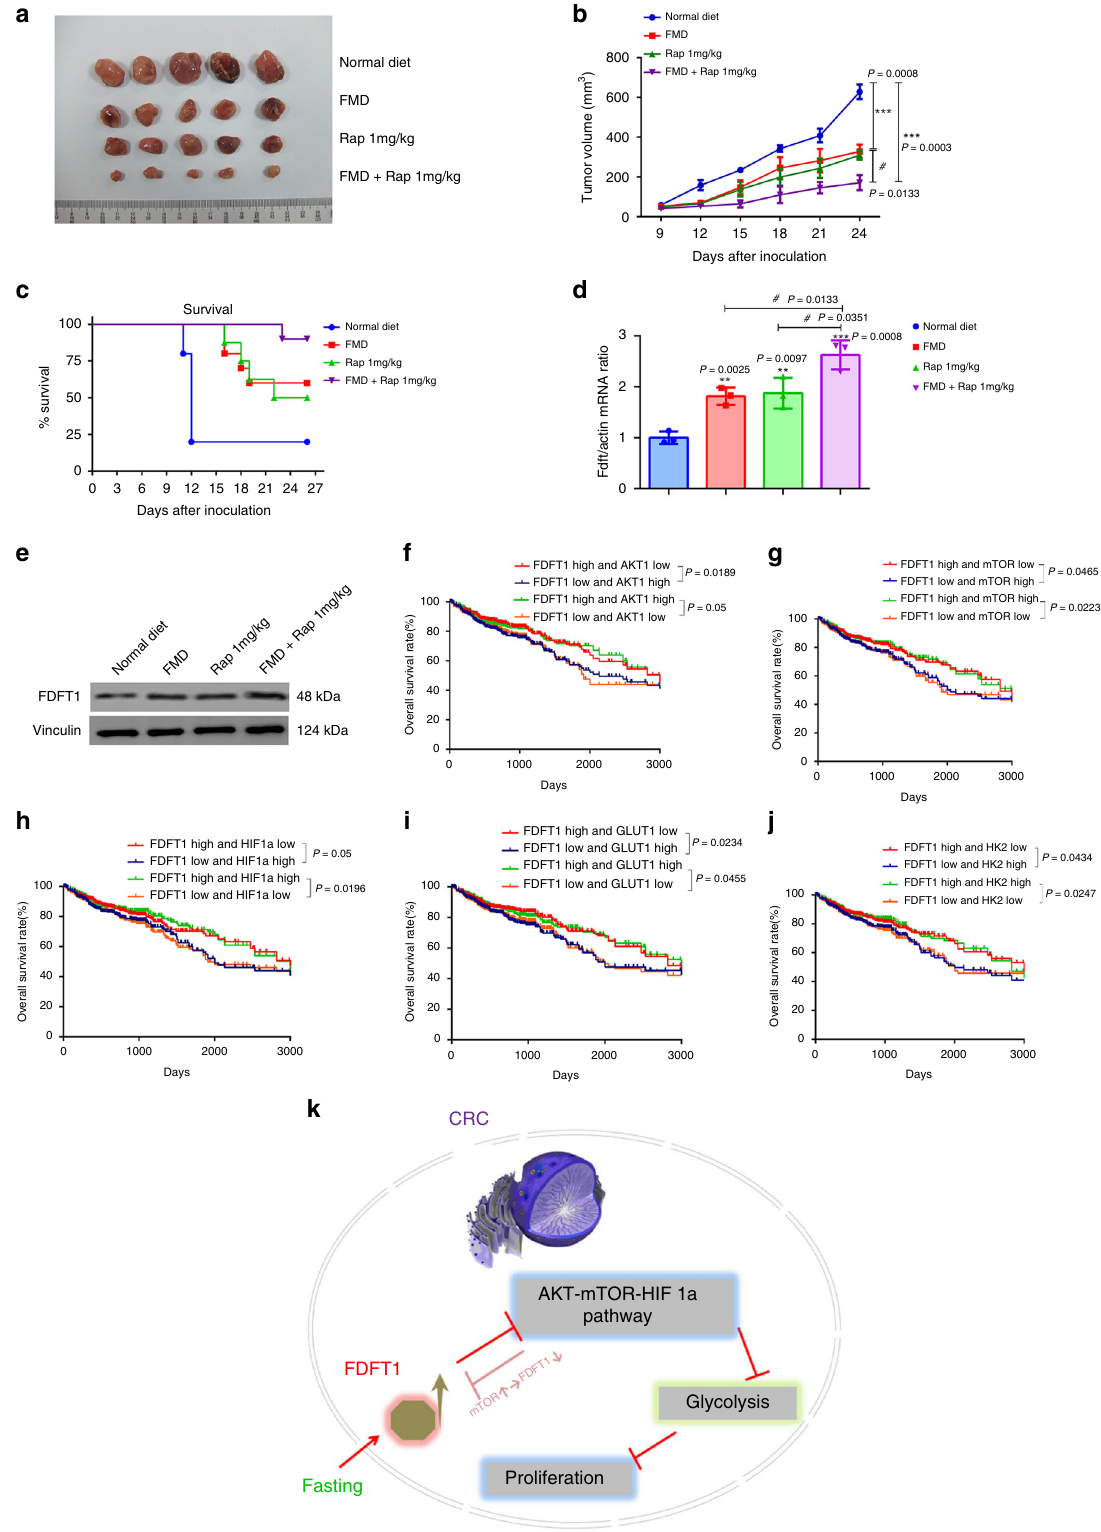
Total cholesterol levels . The total cell cholesterol levels were measured by a cholesterol/cholesteryl ester quantitation kit (Abcam, ab65359) according to the manufacturers ’ instructions. Statistical analysis . The experiments were repeated at least three times. All data are presented as the means ±SDs. SPSS 17.0 software (IBM, USA) and GraphPad Prism 7.0 software were used for data analysis. Two-sided unpaired Student ’ s